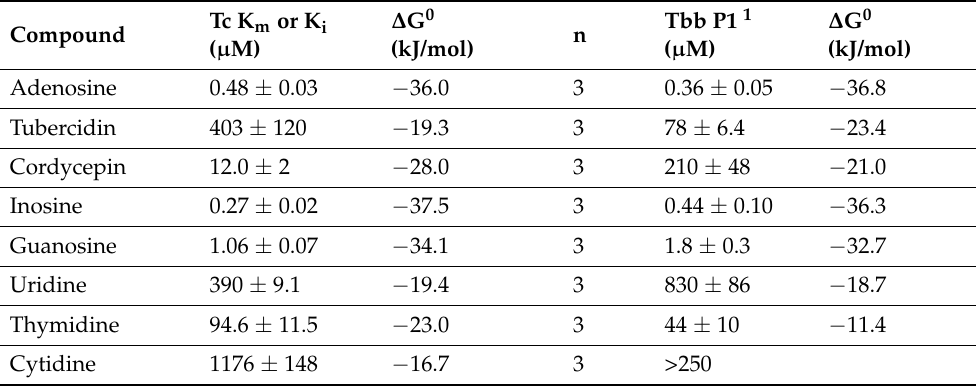
Table 1. K m and K i values for nucleosides on the transport of [ 3 H]-adenosine by T. congolense IL3000 and of T. b. brucei